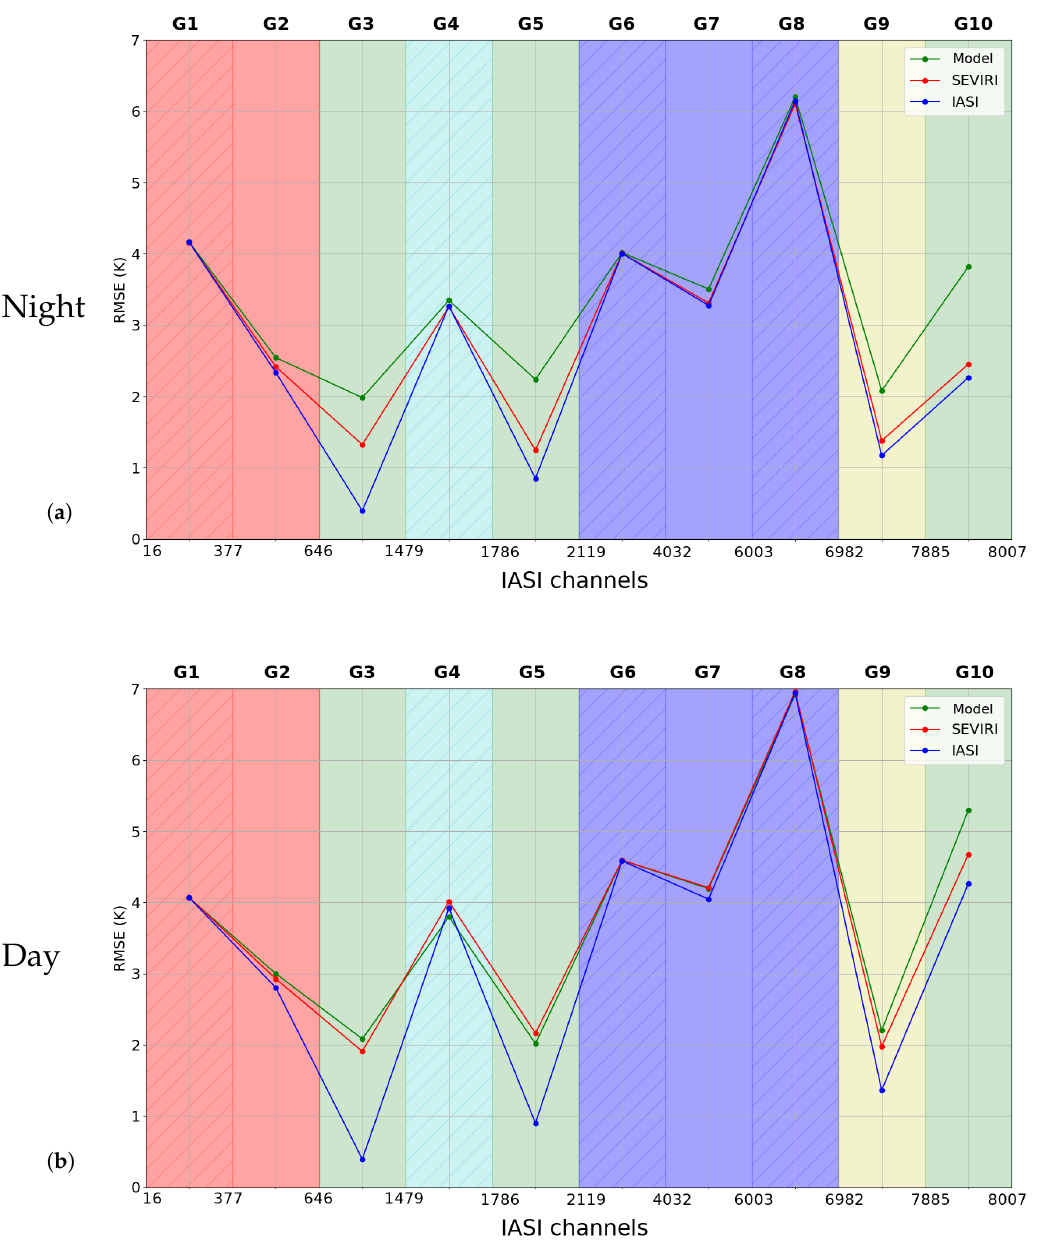
Figure 11. Nighttime ( a ) and daytime ( b ) root mean square errors related to simulations of IASI brightess temperatures using model LST (green line), SEVIRI LST (red line) and IASI LST (blue line) of surface (green), Temperature (orange), ozone (cyan), water vapour (blue) and solar (yellow) sensitive channels. Hatched areas of the figure correspond to channels that present very small sensitivity to LST.